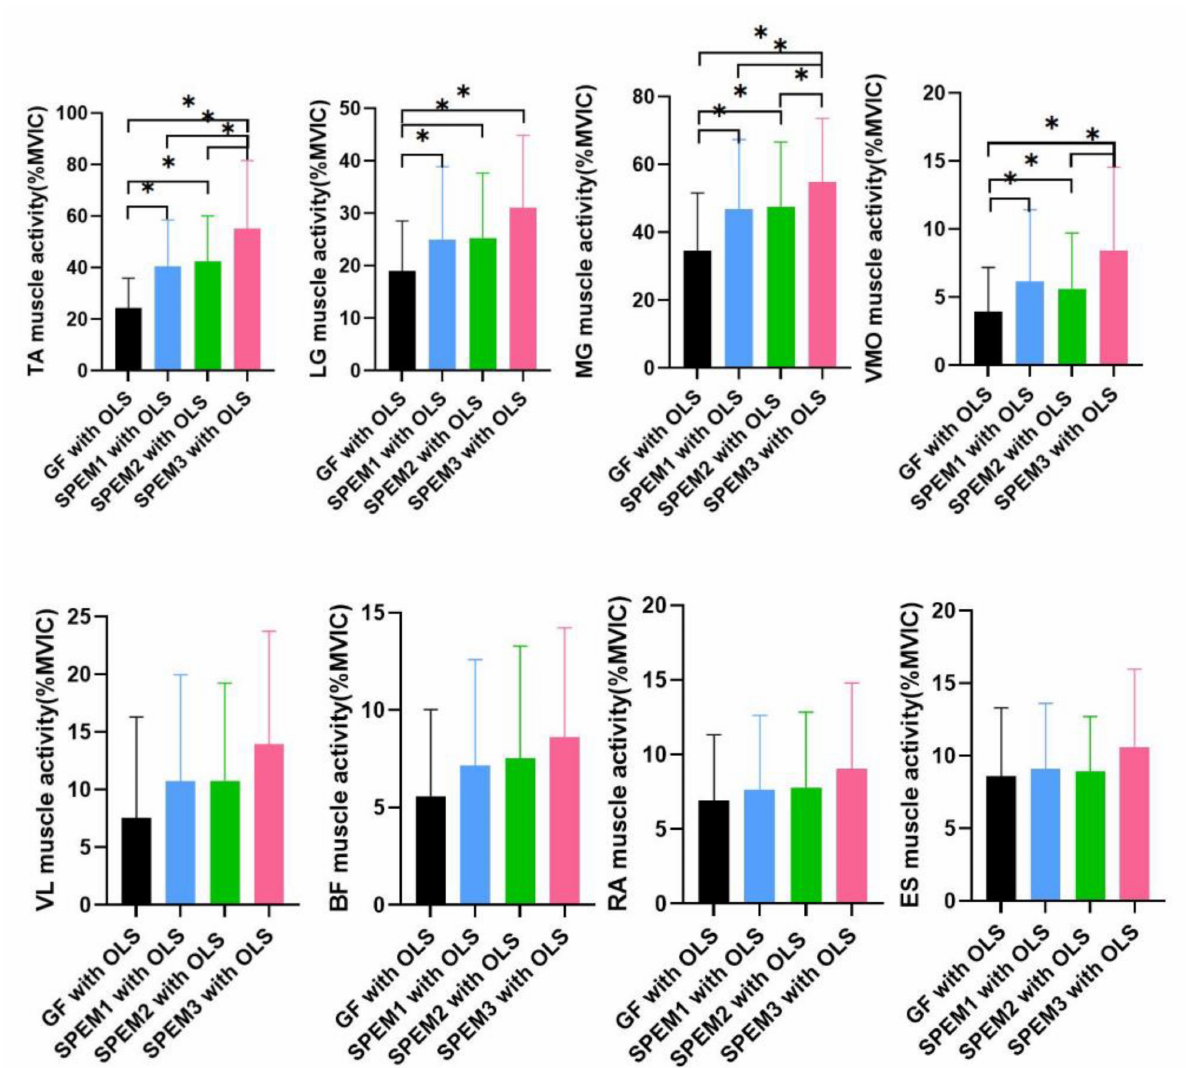
Figure 5. Comparison of four exercises on the trunk and lower extremity muscle activity. * Statistical significance p <